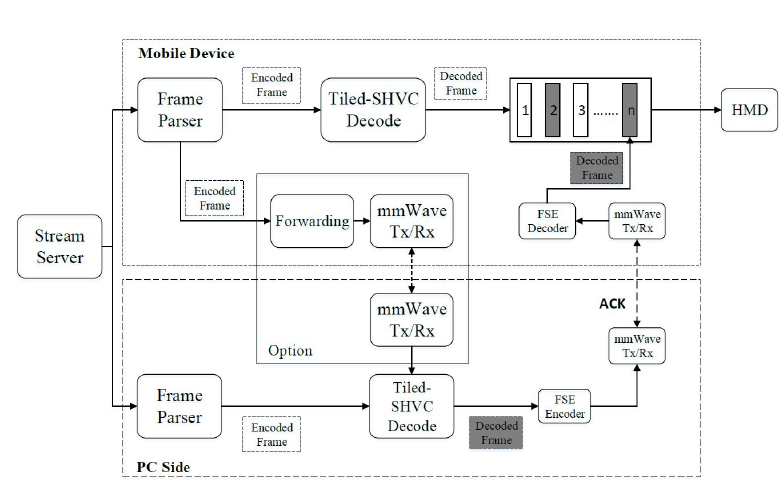
Figure 12. The PC offloading system and the first synchronization